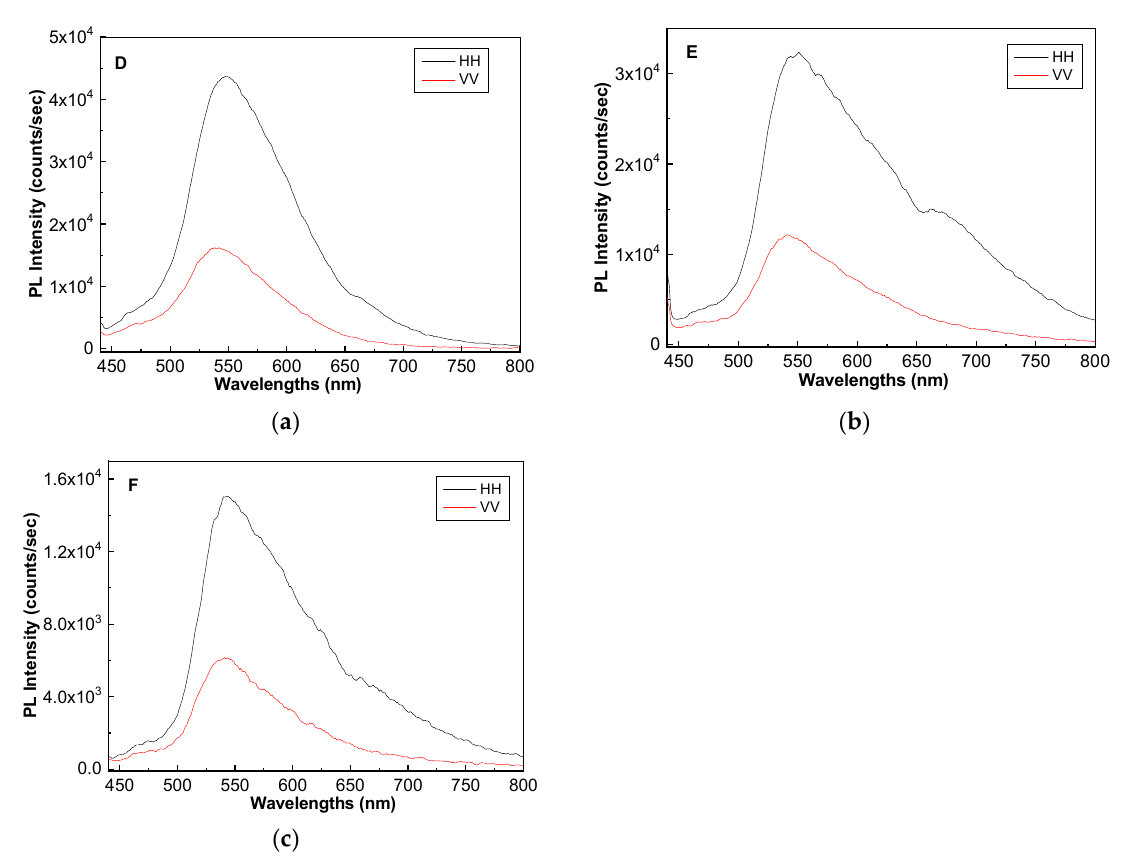
Figure 9. Polarized PL spectra of the composite materials based on the POPD-PVDF blends and DWNTs labeled with D ( a ), E ( b ) and F ( c ). All PL spectra were recorded at the excitation wavelength equal to 420 nm.